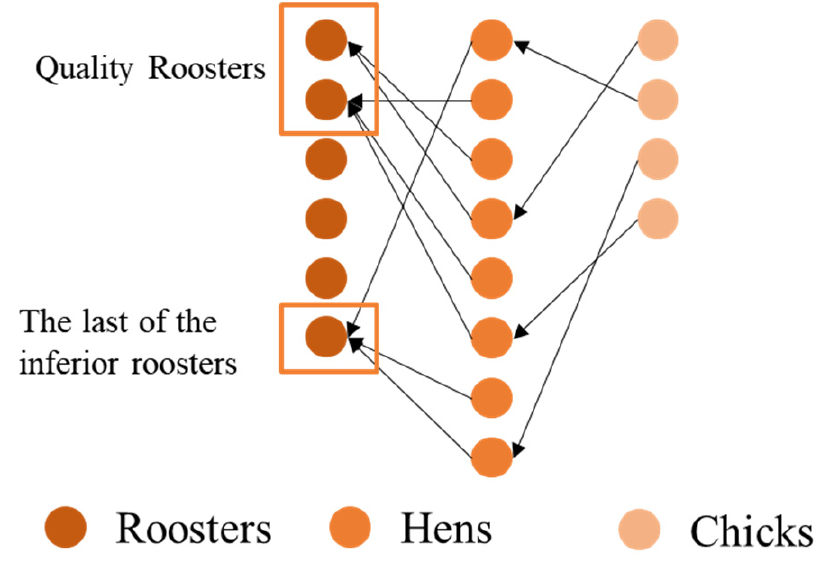
Figure 2. Rooster-binding following strategies.